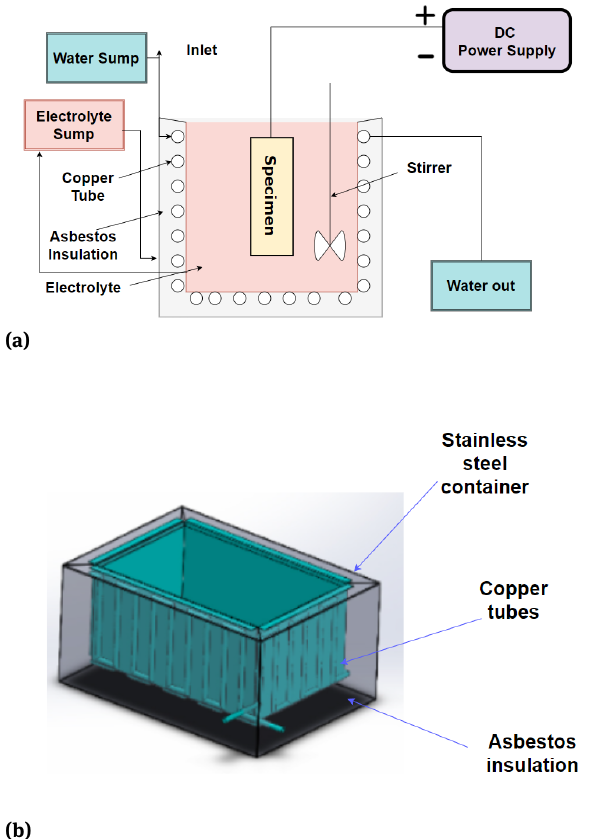
Figure 1: a) Schematic setup of plasma arc oxidation method with controlled cooling; b) Electrolyte tank with cooling